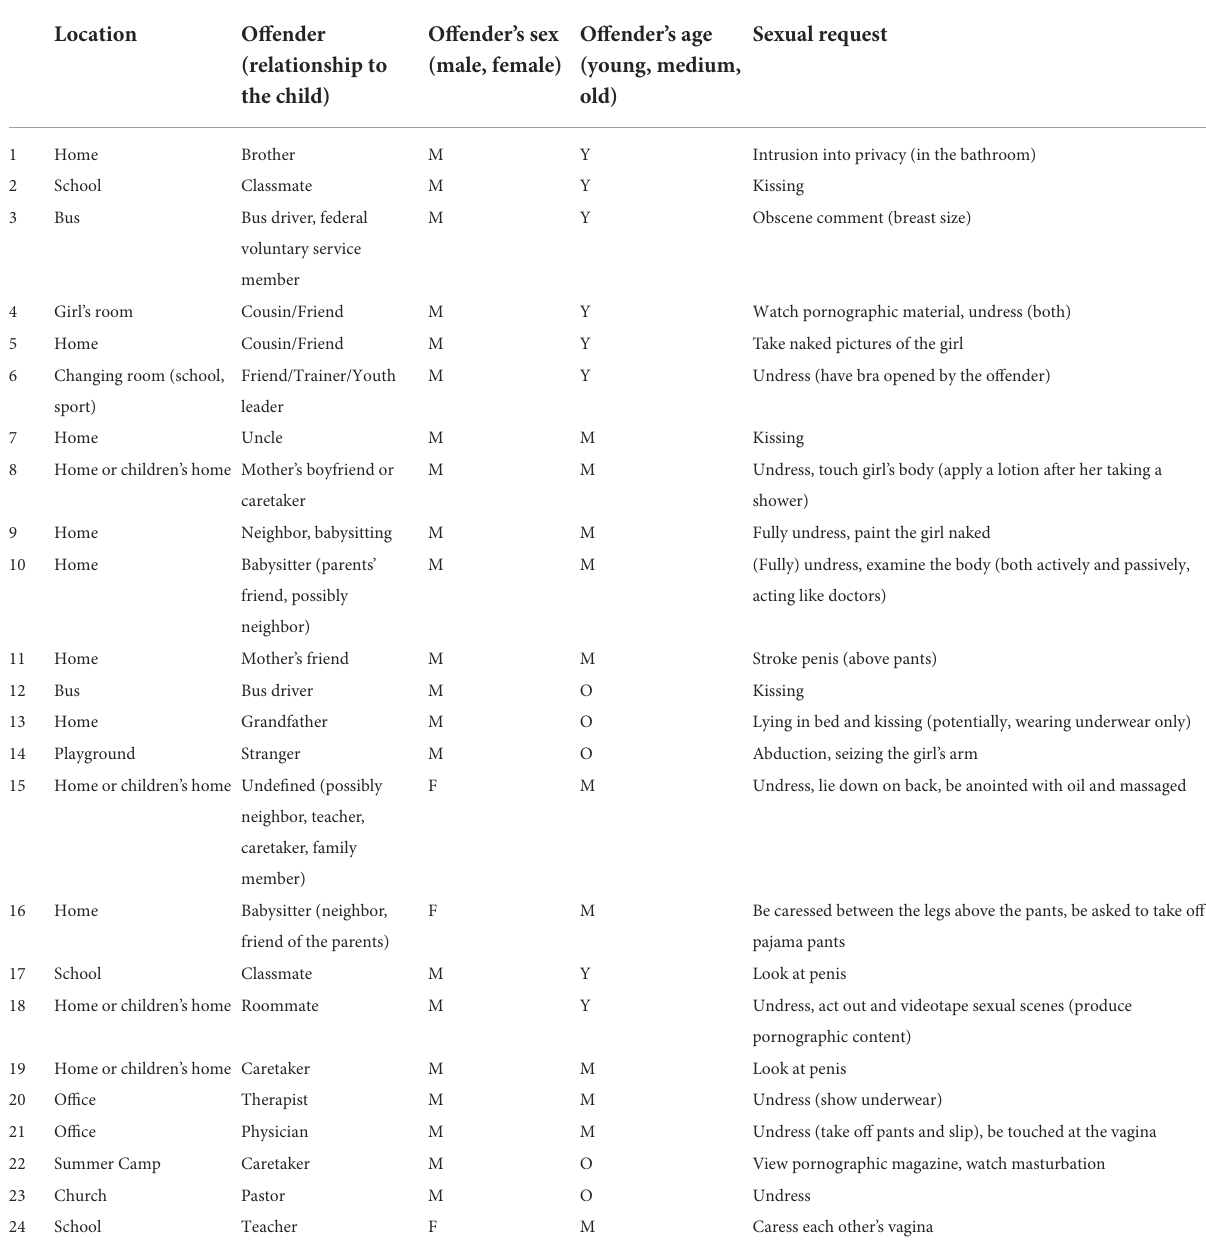
TABLE 1 Video vignettes used for the training and the measurements, respectively.